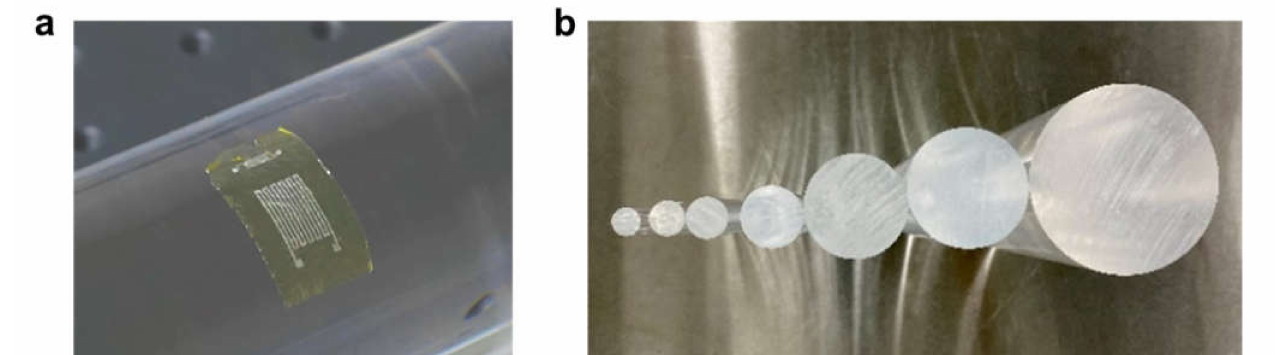
Figure 5. ( a ) A certain bending angle is introduced in the device by attaching the device to an acrylic cylinder rod. ( b ) Acrylic cylinder rods with increased radii of 11, 13, 17, 23, 34, 45, and 67 mm.